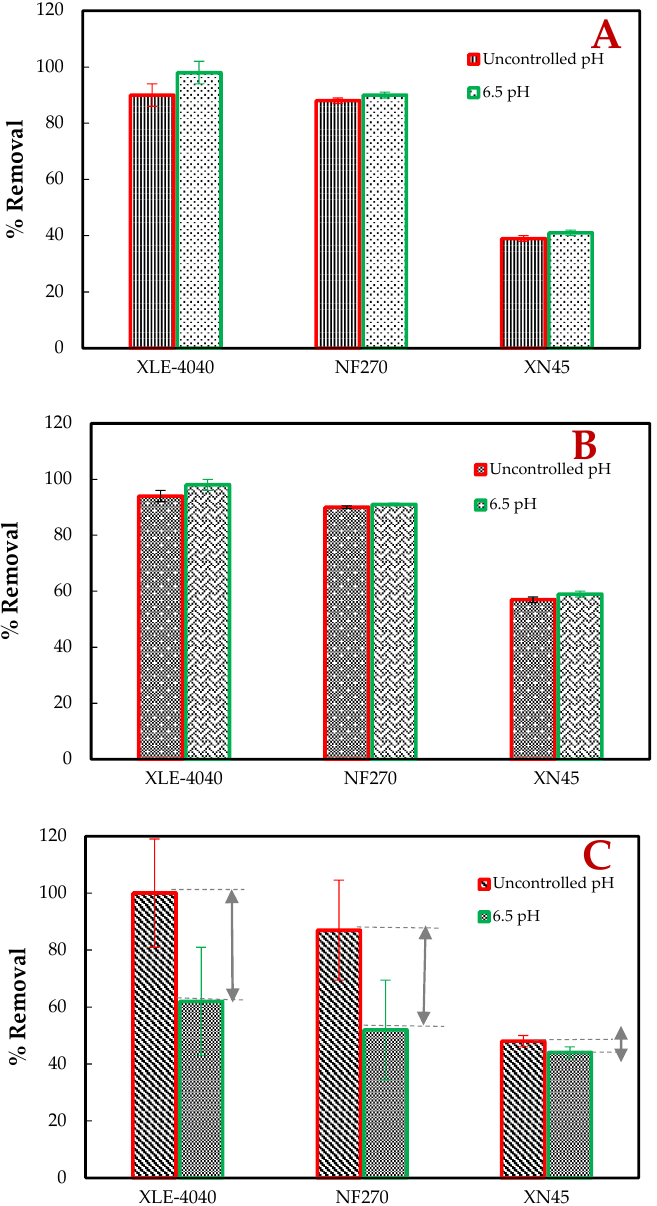
Figure 4. The measured effluents of the UF, NF, and RO membrane treatment at uncontrolled and controlled 6.5 pH pilot plant condition. Phosphate ( A ), Phosphorous ( B ), and Ammonia removal ( C ).